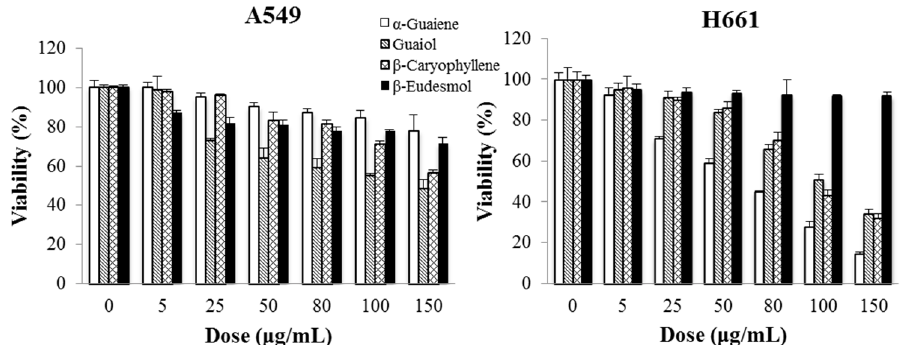
Figure 10. Cytotoxicities of α -guaiene, ( − )-guaiol, β -caryophyllene and β -eudesmol on A549 and H661 cells for 48 h treatment.